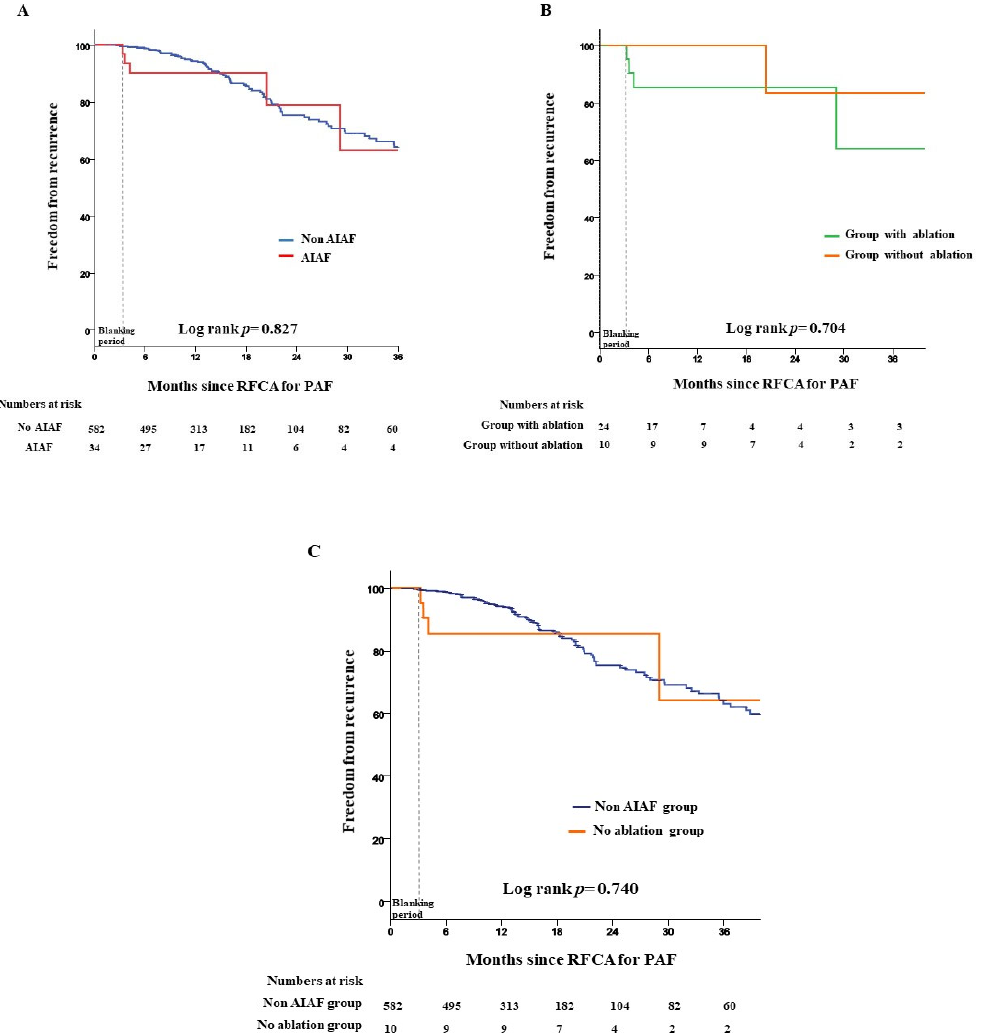
Figure 4. Kaplan–Meier analysis of freedom from recurrence. ( A ) Recurrence rate between adenosine-induced atrial fibrillation and no adenosine-induced atrial fibrillation. ( B ) In the AIAF group, the recurrence rate between the group with ablation for trigger site of AIAF and group without ablation. ( C ) Recurrence rate between non ‐ adenosine ‐ induced atrial fibrillation group and group without ablation. AIAF = adenosine induced atrial fibrillation; RFCA = radiofrequency catheter ab ‐ lation; PAF = paroxysmal atrial fibrillation.